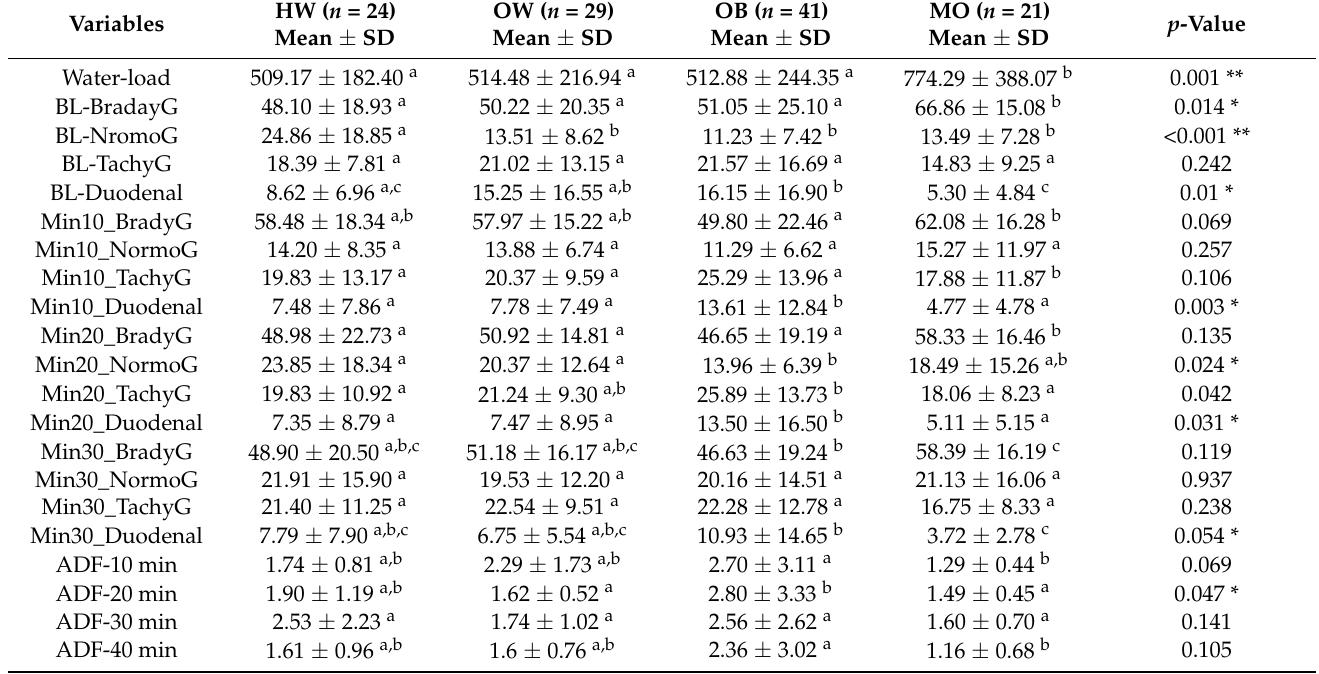
Table 3. EGG patterns among study subgroups stratified by subgroups, n = 115.